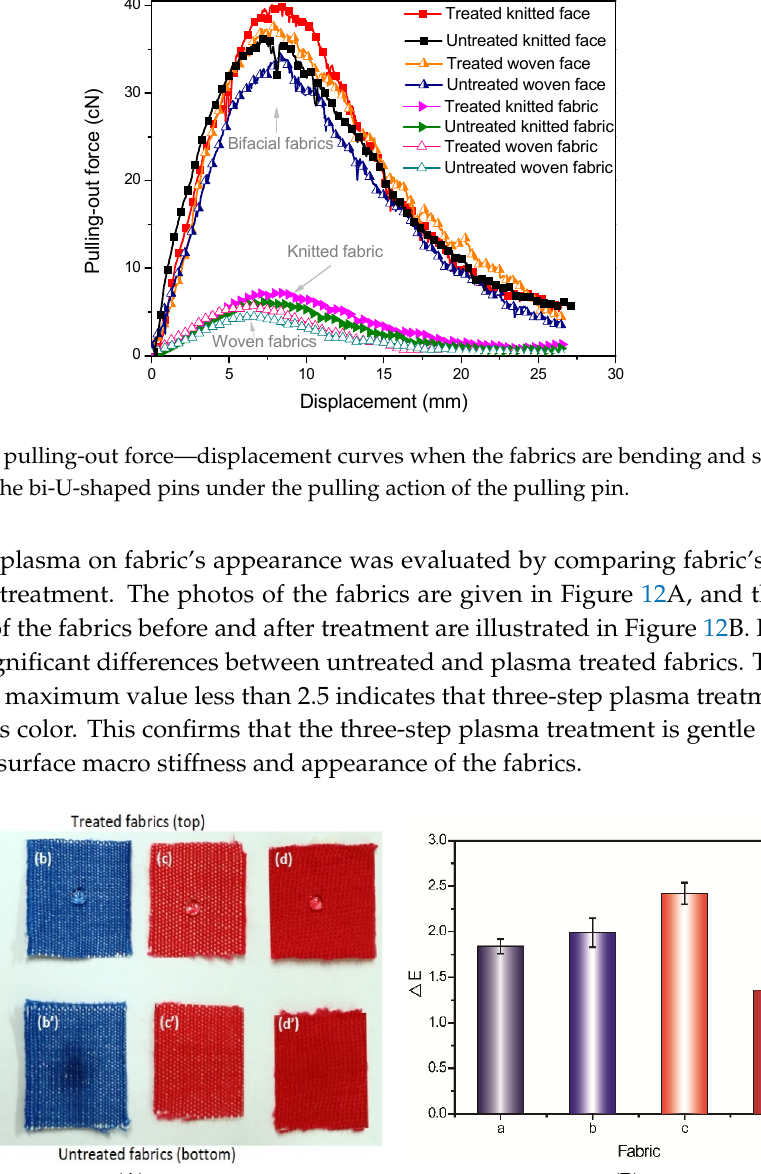
Figure 12. ( A ) Photos of the (a) knitted face of the bifacial fabric, (b) woven face of the bifacial fabric, (c) woven fabric and (d) knitted fabric with the treated samples at the top and untreated samples at the bottom; ( B ) the colour variations ( Δ E ) of the fabrics before and after plasma treatment.